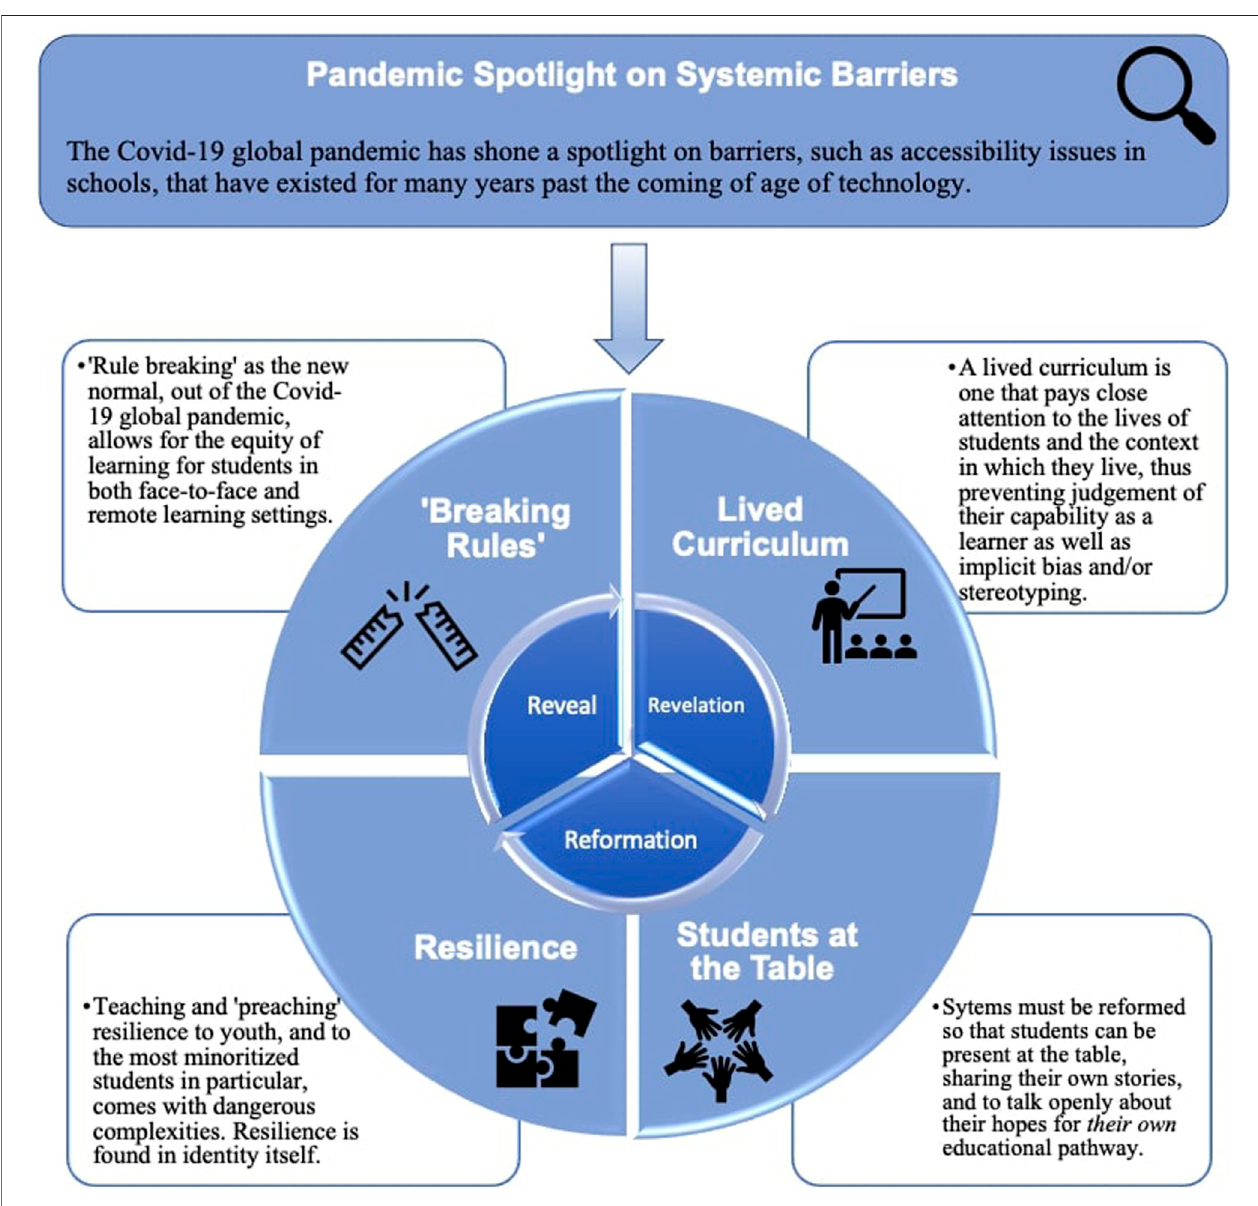
FIGURE 2 | 3R framework intersection with themes/results (Ciuffetelli Parker and Conversano).